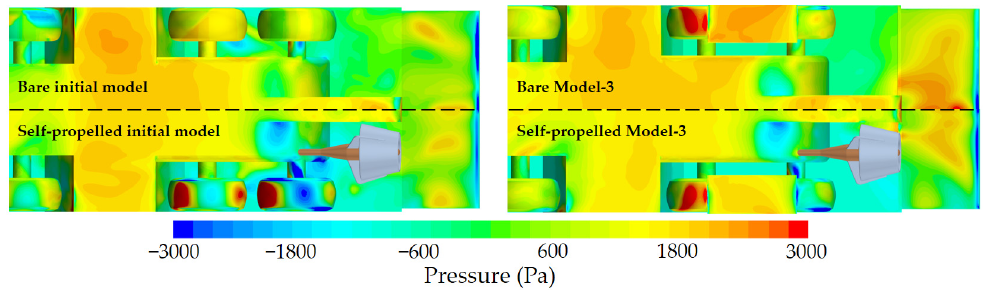
Figure 26. Pressure distribution of the initial model and Model-3 in bare state and self-propelled state.